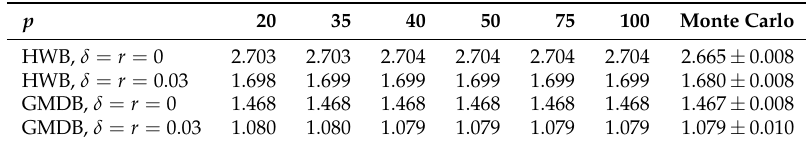
Table 1. Price estimates for δ = r and varying p . HWB, high-water benefit; GMDB, guaranteed minimum death benefit.